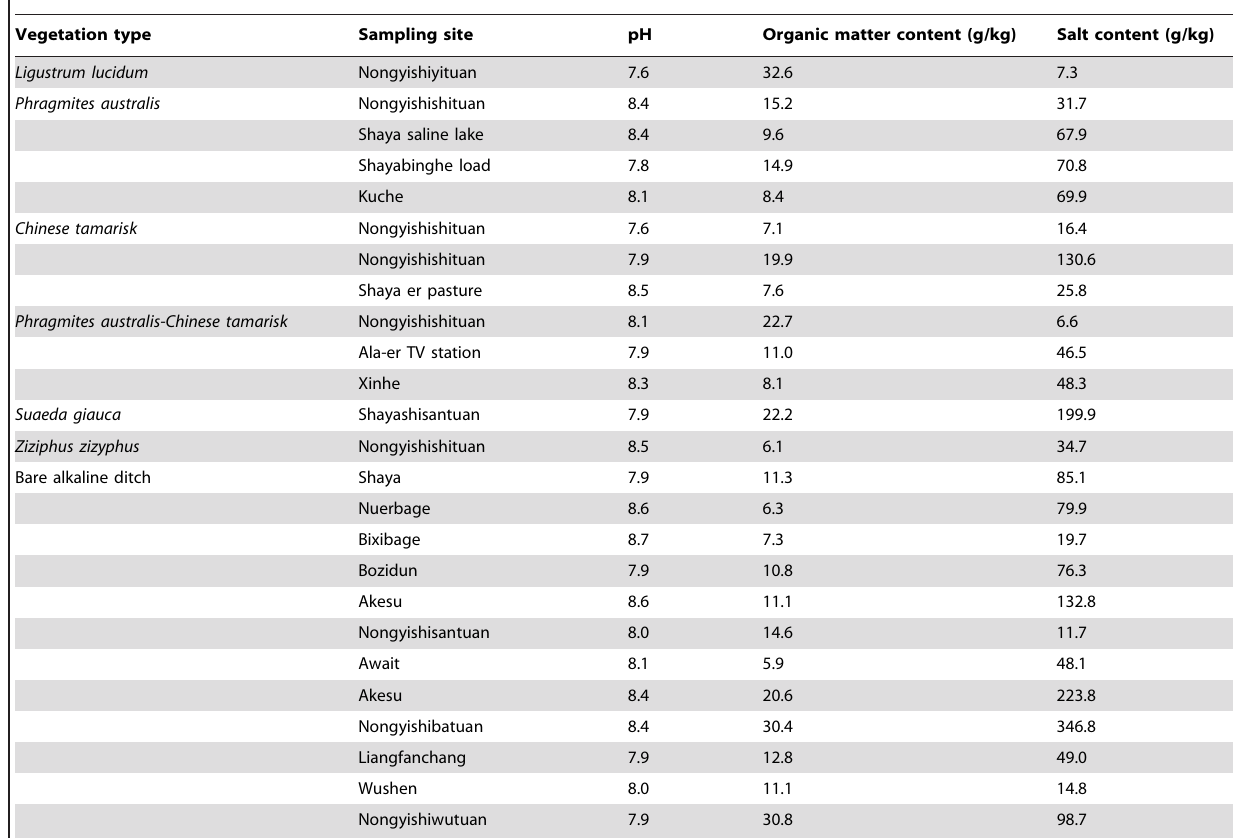
Table 1. The characteristics of 25 saline-alkaline soils.